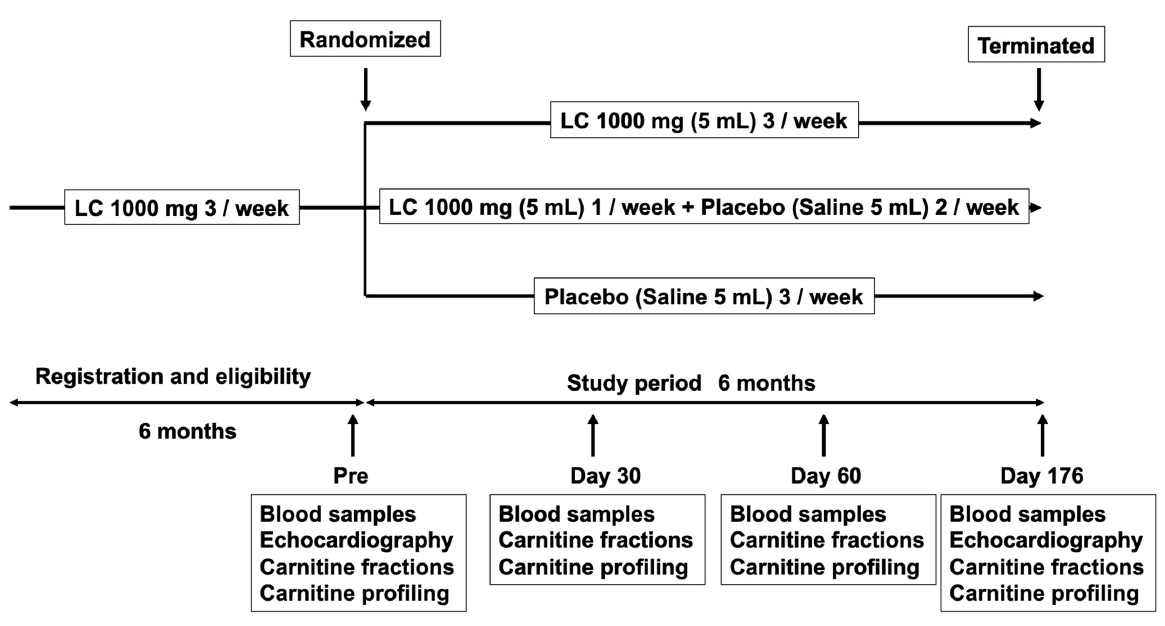
Figure 2. Trial design. Patients were randomized to LC 1000 mg 3/week, LC 1000 mg 1/week + placebo 2/week, and placebo 3/week groups and followed up for six months. Blood samples, including carnitine fractions and profiling, were examined before the study period, day 30, day 60, and day 176 of the study period. Echocardiography was evaluated before and on day 176 of the study period. LC: L-carnitine.